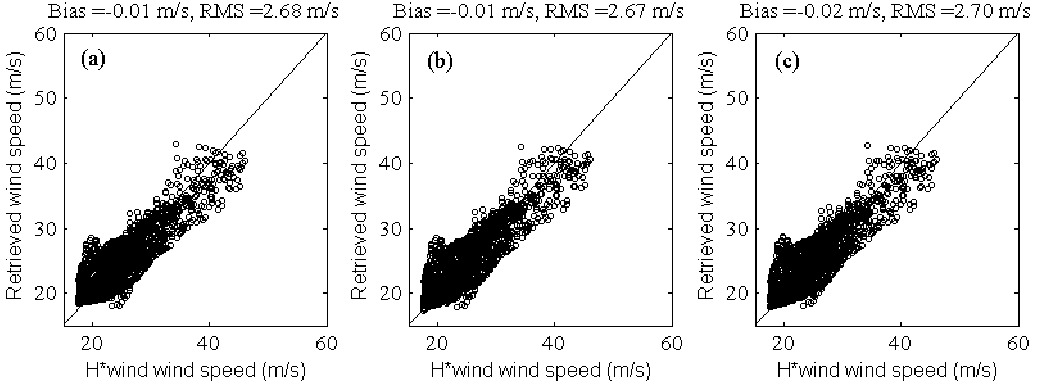
Figure 3. H*wind analysis data versus the retrieved wind speeds over hurricane Frances (2004): ( a ) using the Ellison model and the Reynolds weekly analysis data; ( b ) using the Klein-Swift model and the Reynolds weekly analysis data; and ( c ) using the Klein-Swift model and a fixed SST (29 °C).